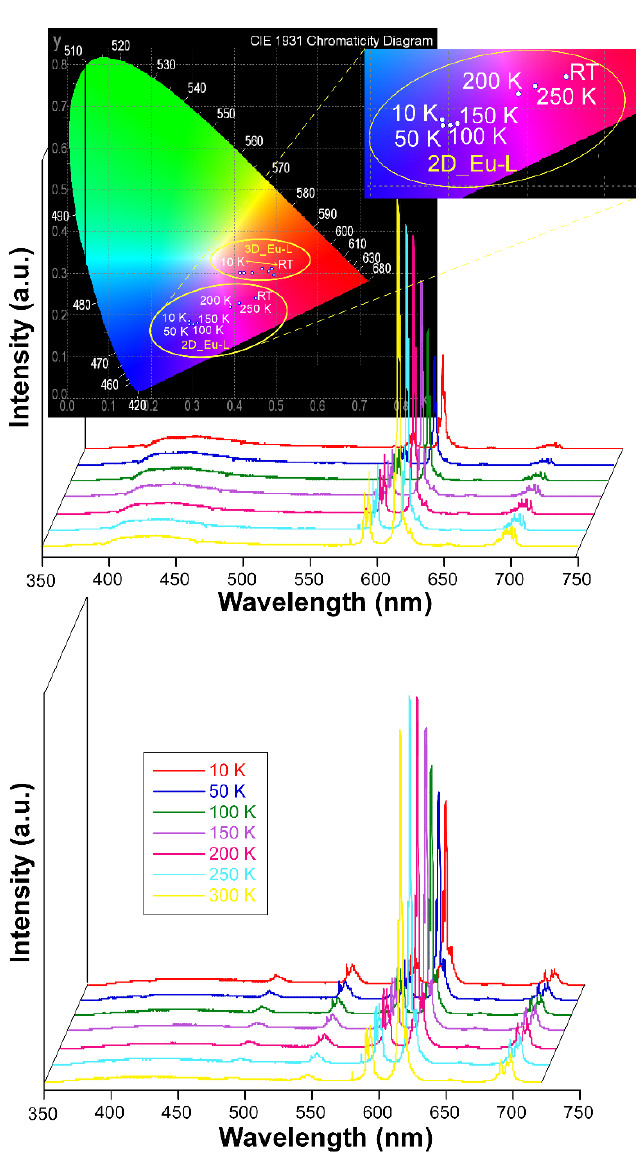
Figure 6. Variable temperature emission spectra of compounds 2D_Eu-L and 3D_Eu-L recorded under λ ex = 325 nm.